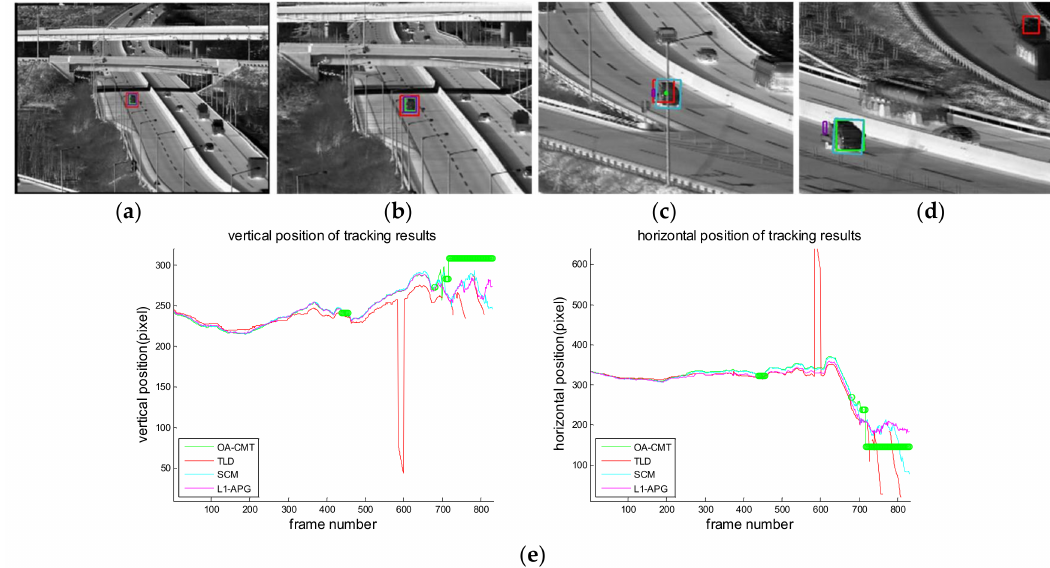
Figure 17. Computer simulation result of imagery ID 2. ( a ) Normal tracking status (original image); ( b ) magnifying interested area; ( c ) L1-APG loses track while the car is partially hidden by a street lamp while OA-CMT turns to memory tracking status and will re-lock successfully after several frames; ( d ) TLD tracks wrong target;( e ) tracking trajectories of each tracker. Around the 600th frame, TLD presents a very different position because of tracking the wrong target (at the time of ( d )). After the 700th frame, the car is hidden by trees, OA-CMT turns to memory tracking status, while other trackers give wandering positions.